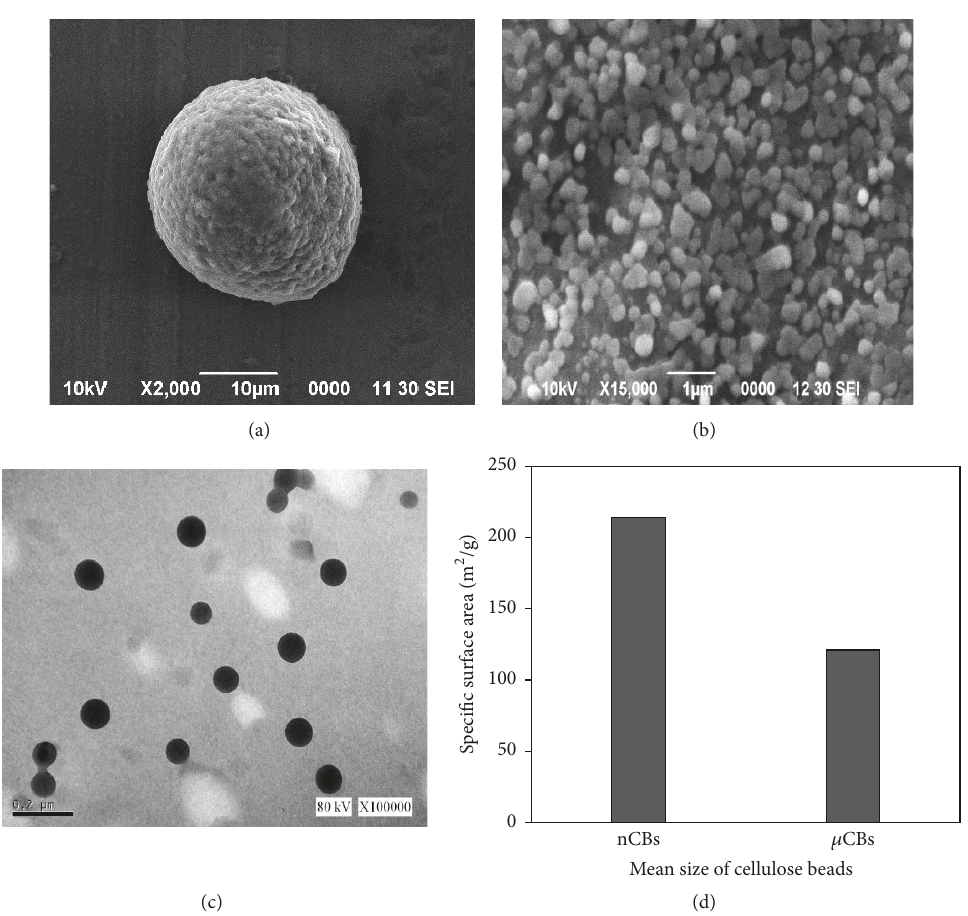
Figure 4: SEM micrographs of cellulose beads, (a) 𝜇 CBs, and (b) nCBs; (c) TEM micrograph of nCBs, and (d) BET specific surface areas of nCBs and 𝜇 CBs.